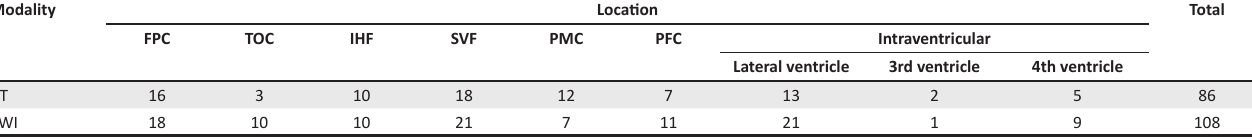
TABLE 2: Correlation between areas of subarachnoid haemorrhage by modality.